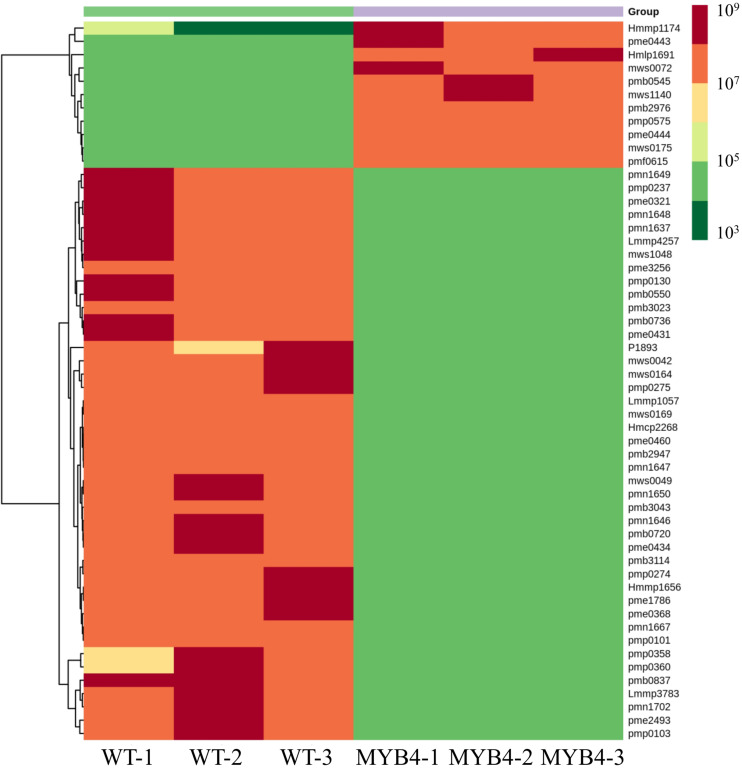
The heat map of the differently accumulated flavonoids in MaMYB4OE plants by metabolomics.